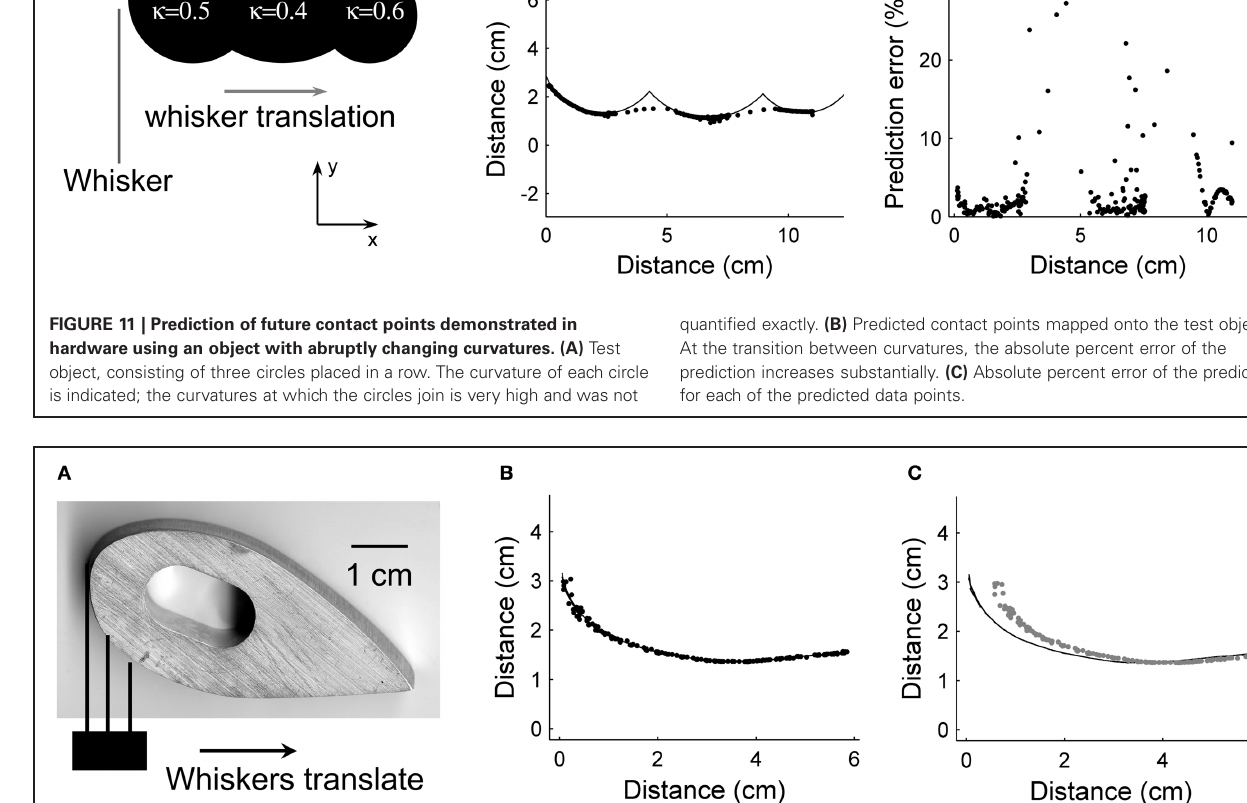
FIGURE 12 | Hardware prediction on an object with gradually changing curvature. (A) Picture of the test object, designed to be a close approximation to a hyperbolic spiral. The whiskers translated along the bottom face of the object from left to right as shown by the